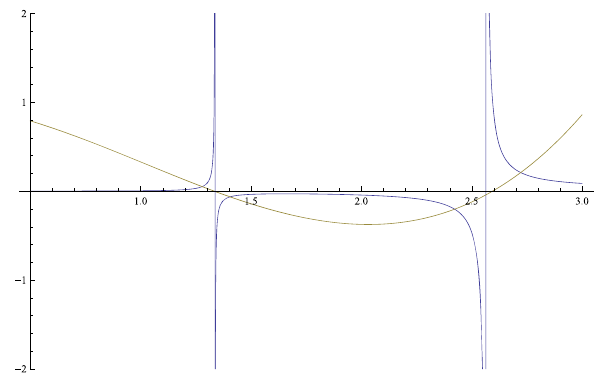
∼ 0 . 16. l and 1 . a 1 a 2